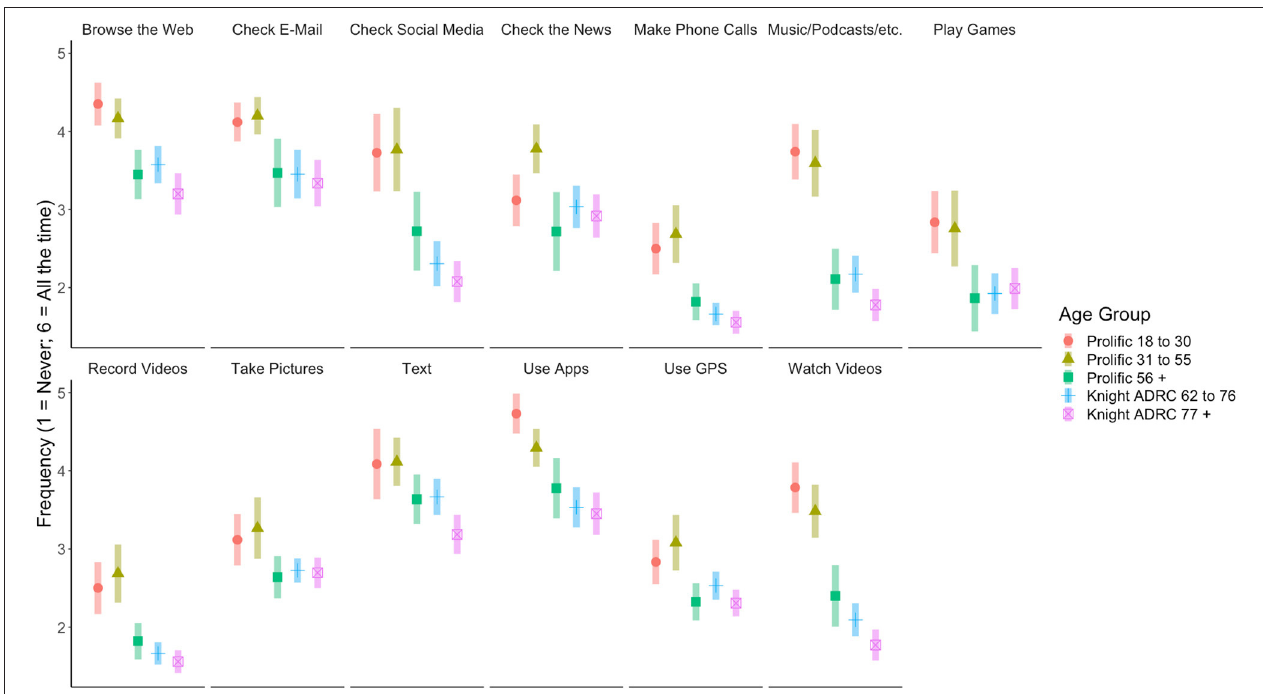
FIGURE 2 | Participants’ reported frequency performing technology-based tasks. Error bars represent 95% confidence interval.